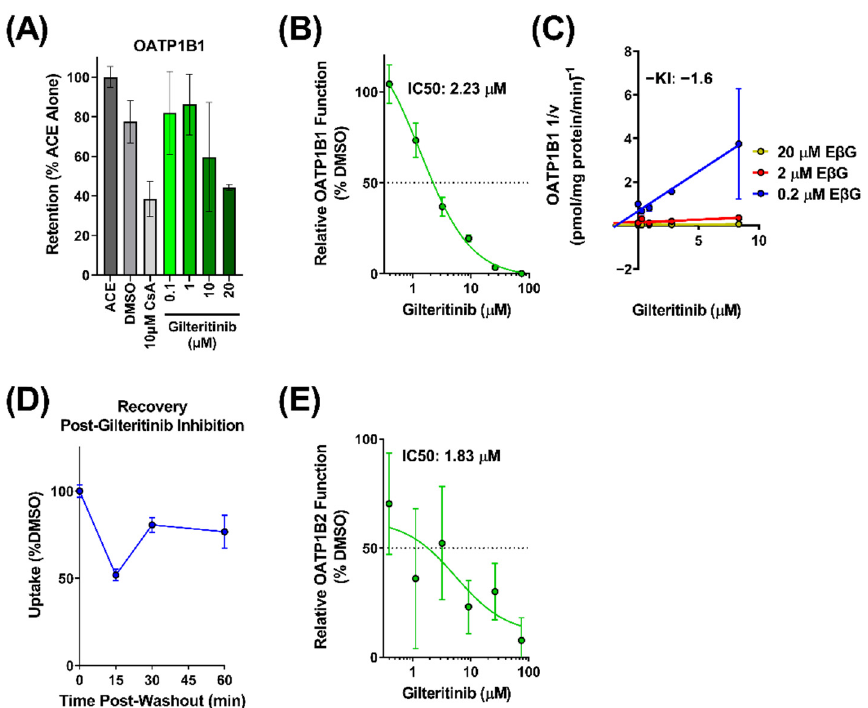
Figure 2. Gilteritinib is a substrate and inhibitor of OATP1B-type transporters. ( A ) Uptake of gilteritinib by OATP1B1 overexpressing HEK293 cells was assessed via competitive counterflow assay. Uptake was measured by accumulation of the fluorescent substrate 8-acetoxypyrene-1,3,6- trisulfonate (ACE) with or without gilteritinib. ( B ) Inhibitory potency of gilteritinib on OATP1B1 overexpressing HEK293 cells compared to vector control cells. Inhibition was determined by the intracellular accumulation of the radiolabeled probe substrate E β G in the presence of gilteritinib at increasing concentrations (0.5–75 µ M). ( C ) Dixon plot showing various concentrations of radiolabeled E β G (0.2, 2, 20 µ M) uptake in the presence of gilteritinib (0.3–8.3 µ M) in OATP1B1 overexpressing HEK293 cells ( D ) Recovery of OATP1B1 function after 15 min treatment of gilteritinib (15 µ M). ( E ) Inhibitory potency of gilteritinib on OATP1B2 overexpressing HEK293 cells compared to vector control cells. Inhibition was determined by the intracellular accumulation of 8-FcA. Data are shown as mean (bars or symbols) and SD (error bars).